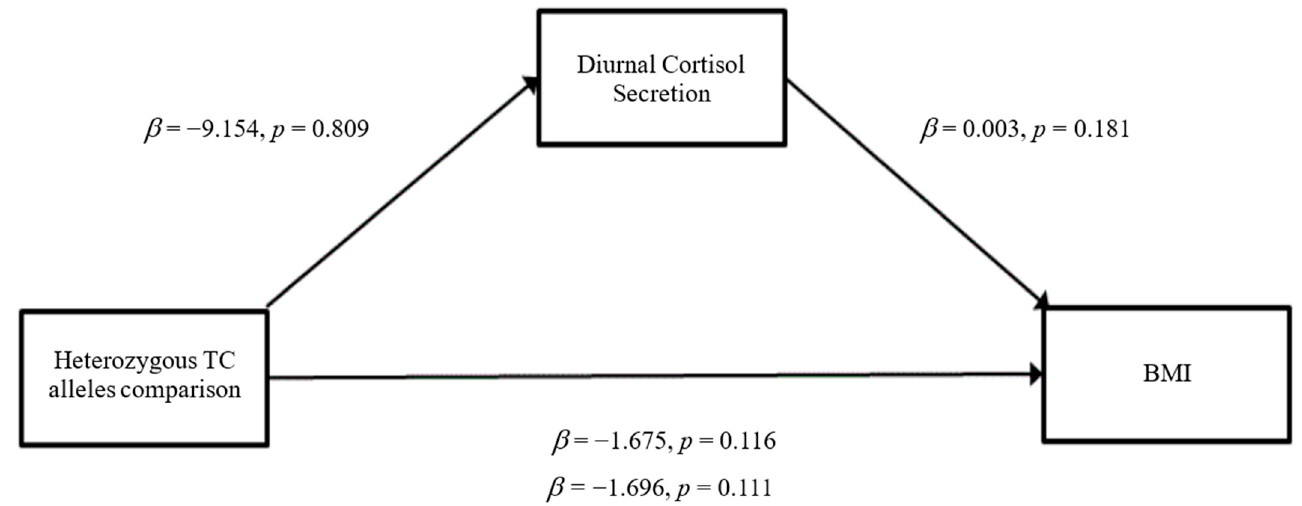
Figure 3. Mediation model for the Heterozygous TC alleles comparison with BMI through the pathway of diurnal cortisol secretion (Model 4).